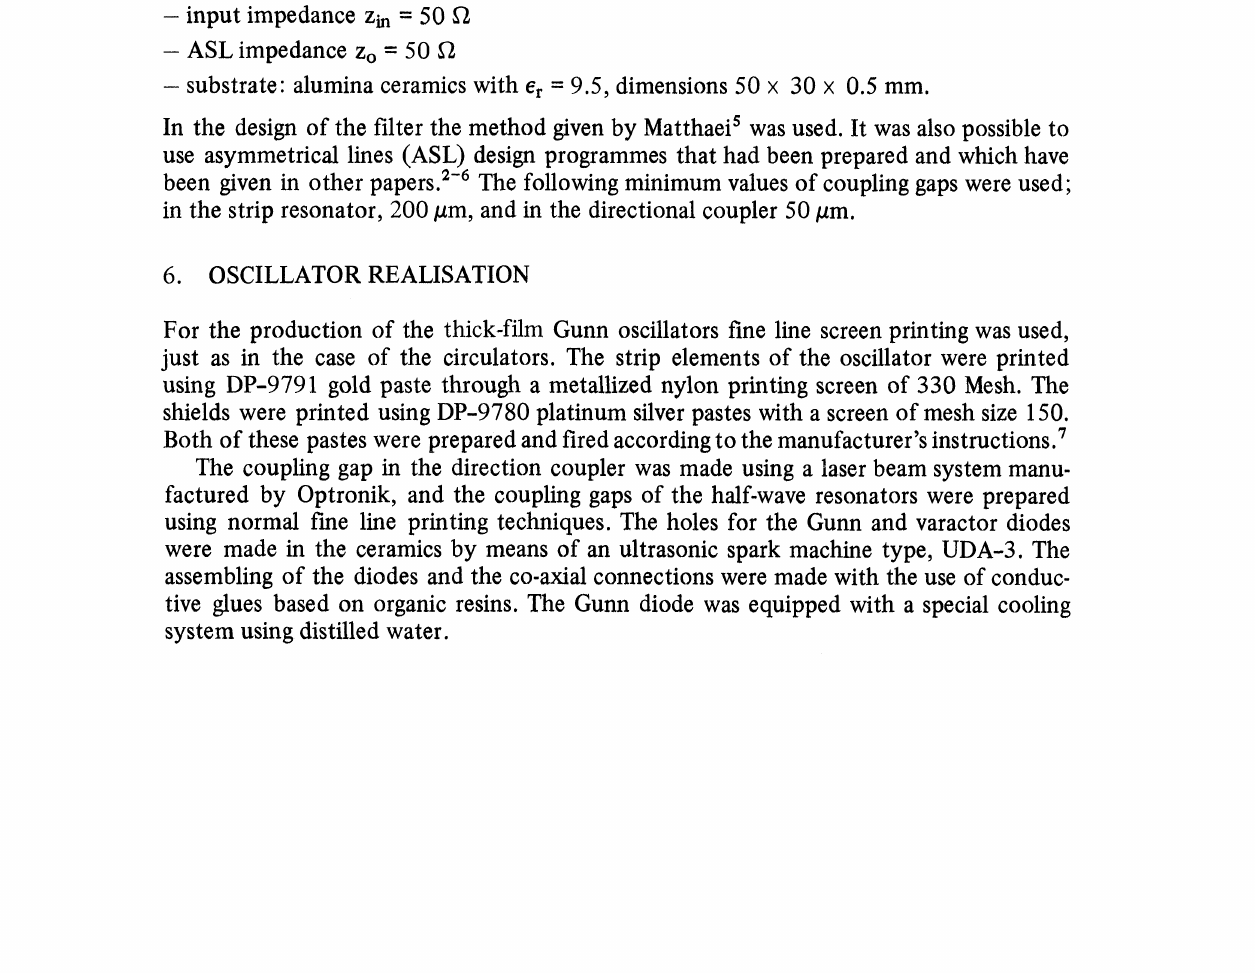
FIGURE 4 Examples of other configurations of Gunn